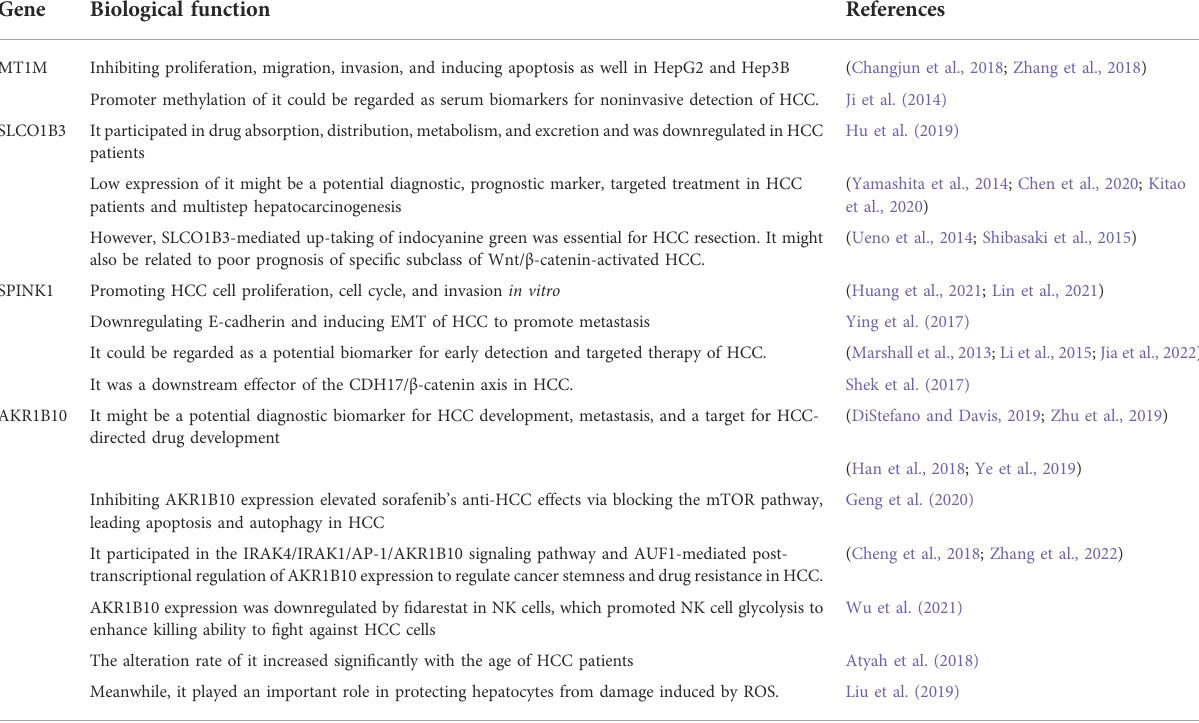
TABLE 1 Various biological functions of four diagnostic-related genes in